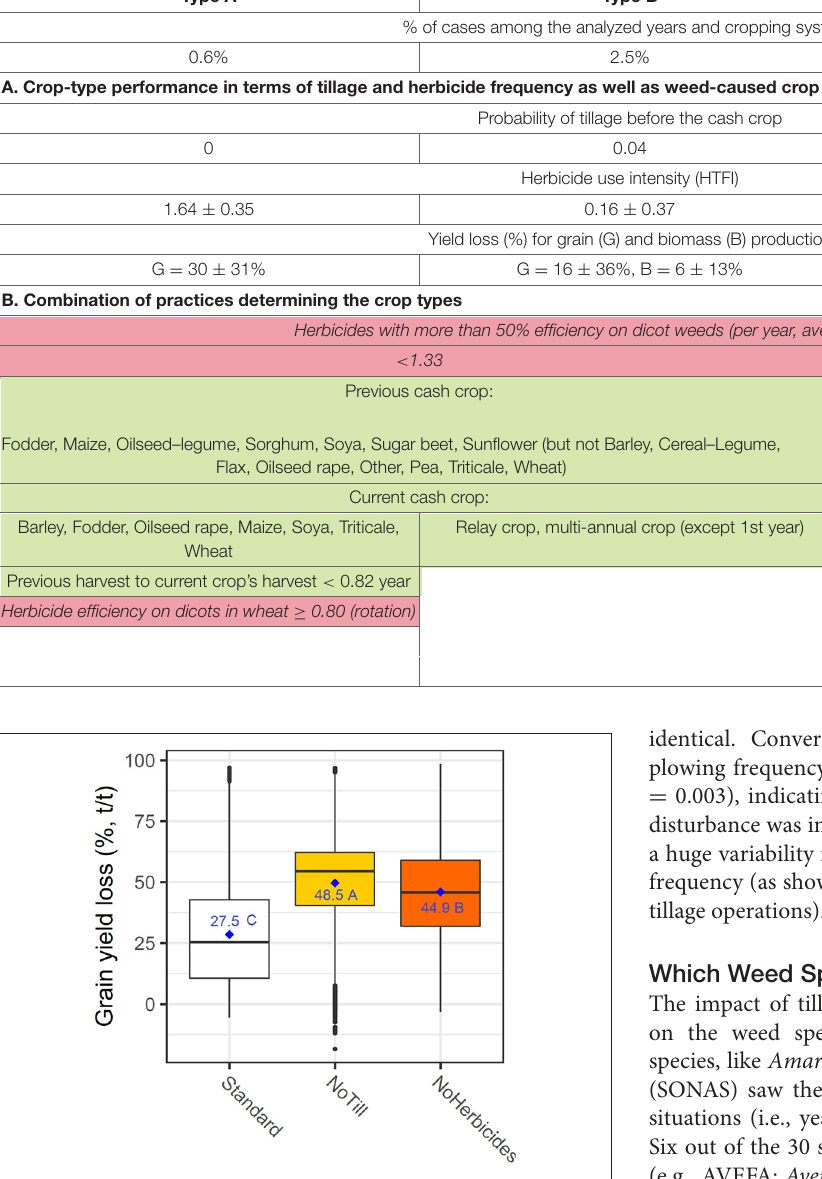
average over the rotation (y = 5.61 + 5.12 x, R ² = 0.10, p